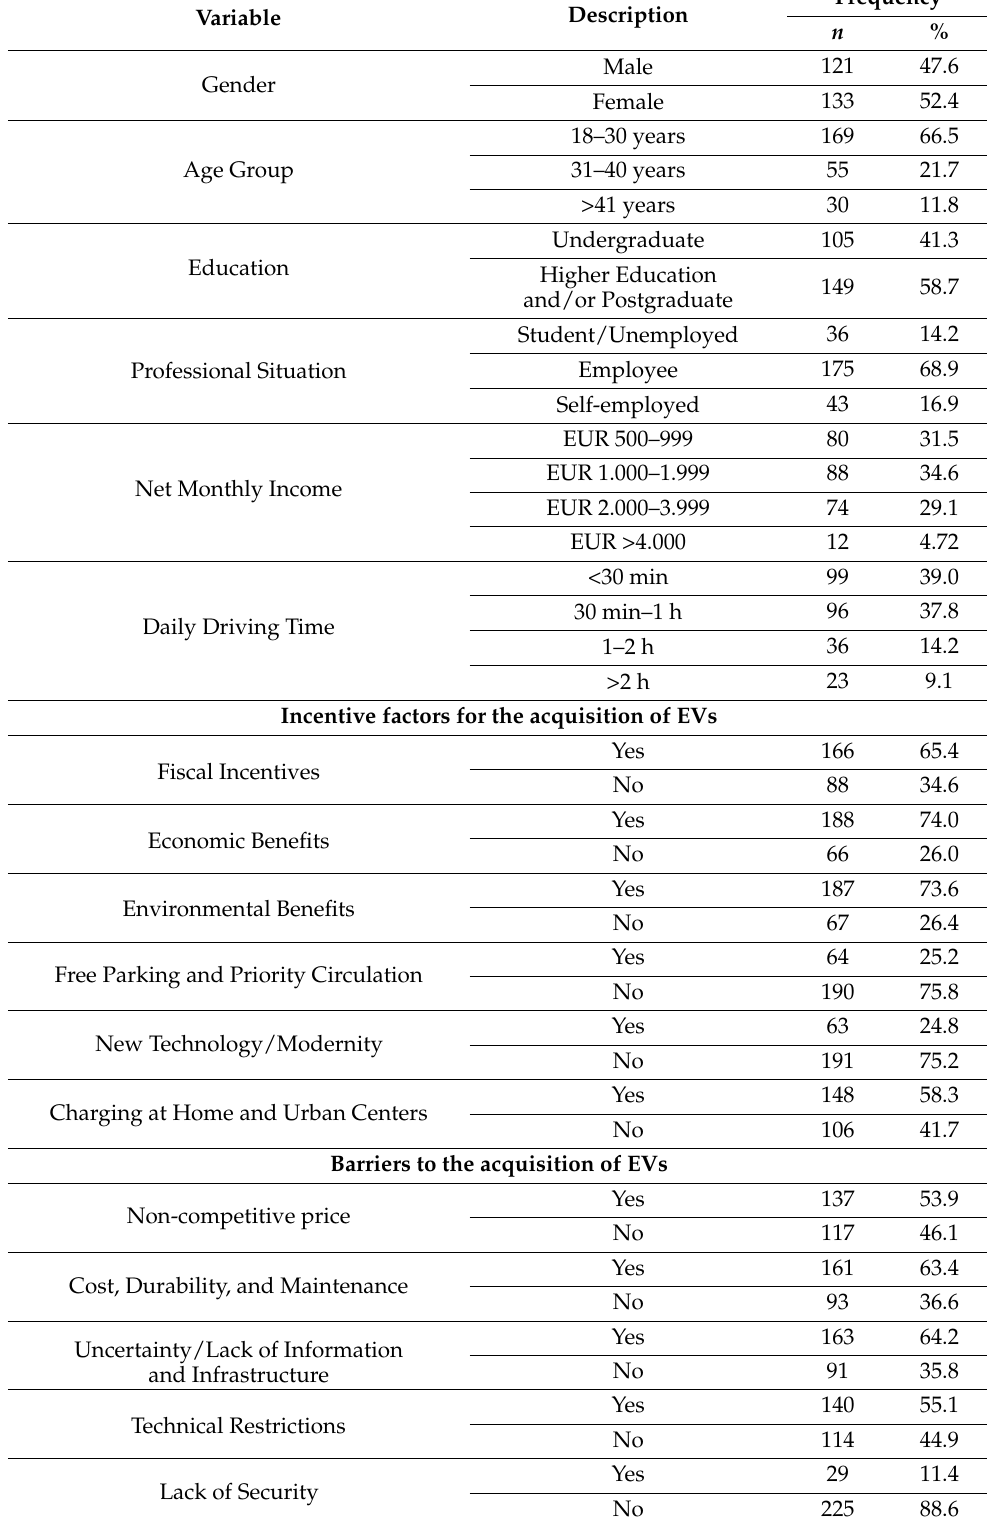
Table 4. Descriptive analysis of respondents to the questionnaire related to the domestic